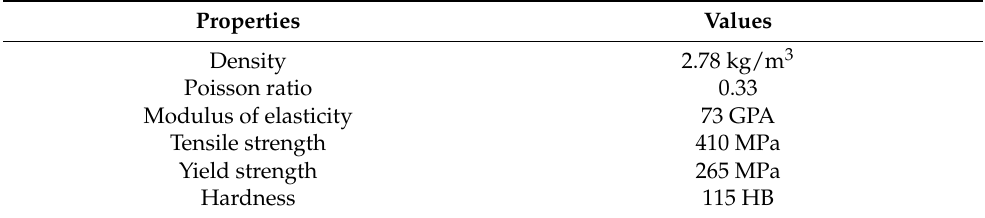
Table 1. Properties of aluminum alloy